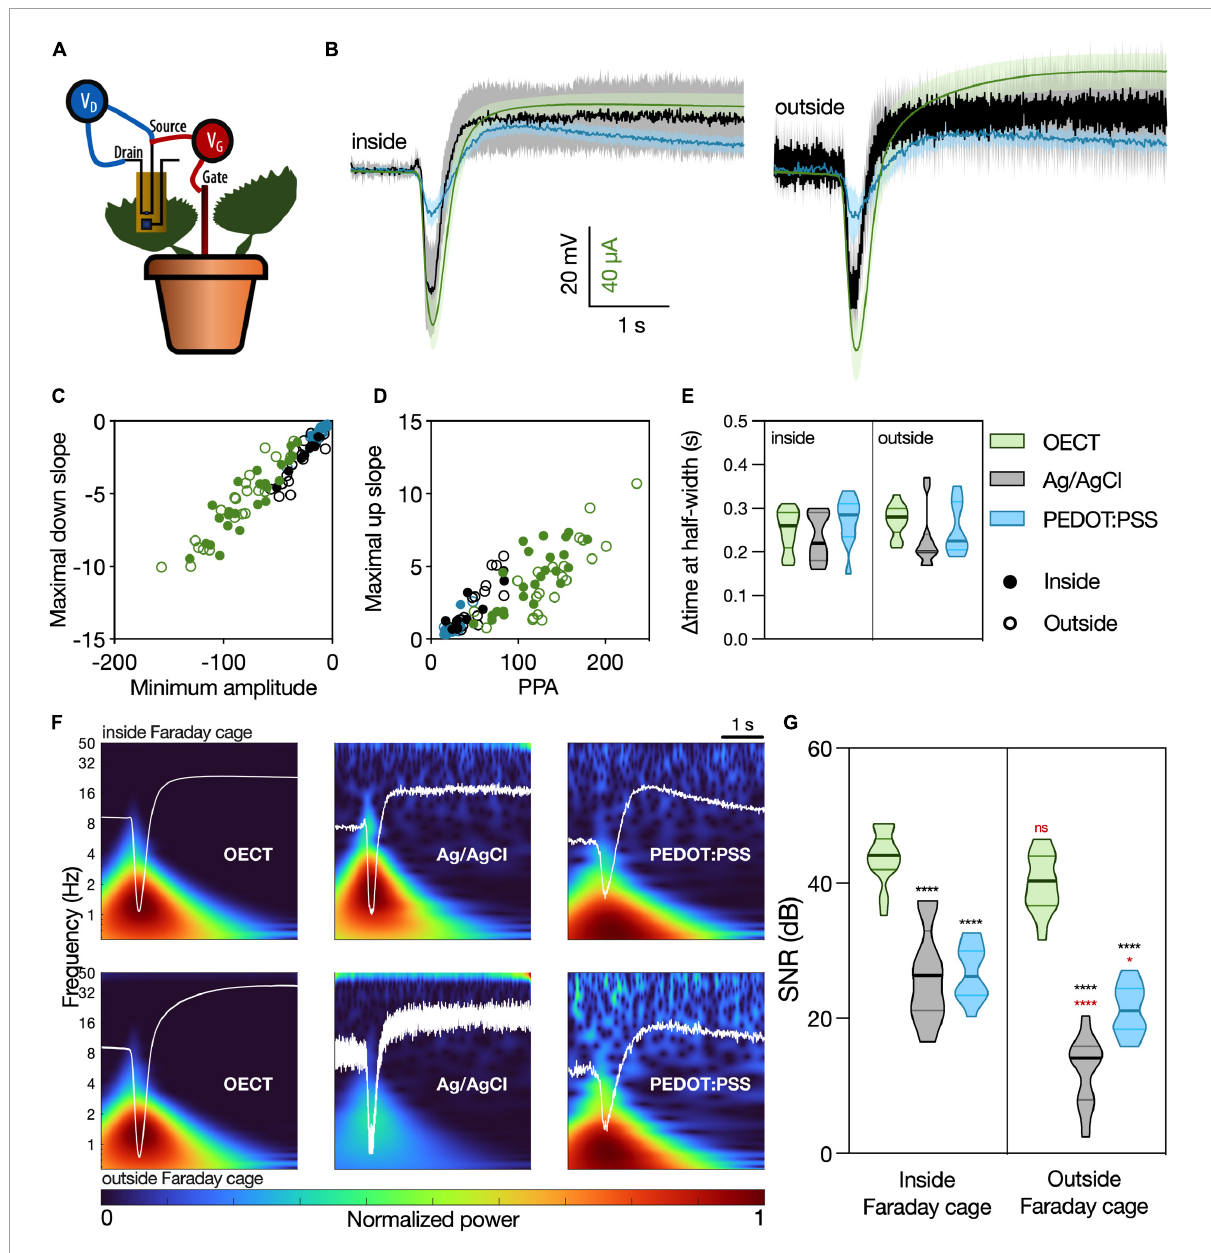
FIGURE3 Venus flytrap (VFT) action potentials recorded with different devices. (A) Schematic representation of the recording setup. The OECT channel was attached on a lobe of a VFT trap, using a commercially available electrophysiology gel as an electrolyte. Gate voltage (V GS ) was applied between source and a Ag/AgCl electrode in the soil. Drain voltage (V DS ) was applied across the OECT channel. For recordings with Ag/AgCl or PEDOT:PSS electrodes, the recording electrodes were attached on the trap, and a Ag/AgCl electrode in soil was used as reference. For the recordings inside of the Faraday cage, an extra Ag/AgCl electrode was placed in the soil and used to ground the whole system. (B) Average waveform acquired with the different devices: OECT (green trace), Ag/AgCl electrode (black trace), and PEDOT:PSS electrode (blue trace). Data represented as mean ± 95% CI. N = 9–24 traps from 4 to 10 independent plants. Quantification of the (C) linear relationship between the maximal down slope and minimum amplitude; (D) linear relationship between the maximal up slope and the peak-to-peak amplitude of the action potential; (E) duration of action potential, characterized by the delta time at half-width. No significant differences were found in any of the considered parameters, using a simple linear regression and statistical comparison of slopes [for panels (C,D) ] or a two-way ANOVA considering the parameters "device" and "Faraday cage" [for panel (E) ]. (F) Time-frequency domain normalized magnitude scalograms of the average waveform acquired with the different devices, inside and outside of the Faraday cage. The average waveform is overlaid in white. (G) Quantification of SNR for the different waveforms, N = 9–20. * p < 0.05, **** p < 0.0001 using a two-way ANOVA considering the parameters "device" and "Faraday cage," followed by Tukey’s multiple comparison test. In black, differences within the same "cage" condition; in red, differences in the same "device" condition. In (E,G) , data are represented in violin plots, where the width of the shaded area represents the proportion of data points at any given zone, with lines at median and